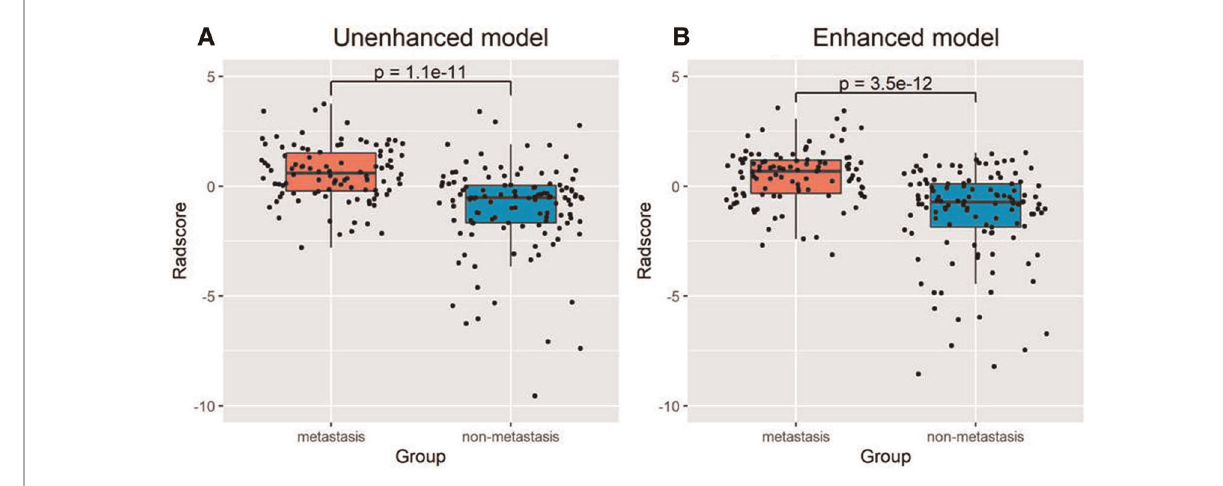
FIGURE 6 Box plot of the Radscore value in the unenhanced (A) and enhanced (B) models.